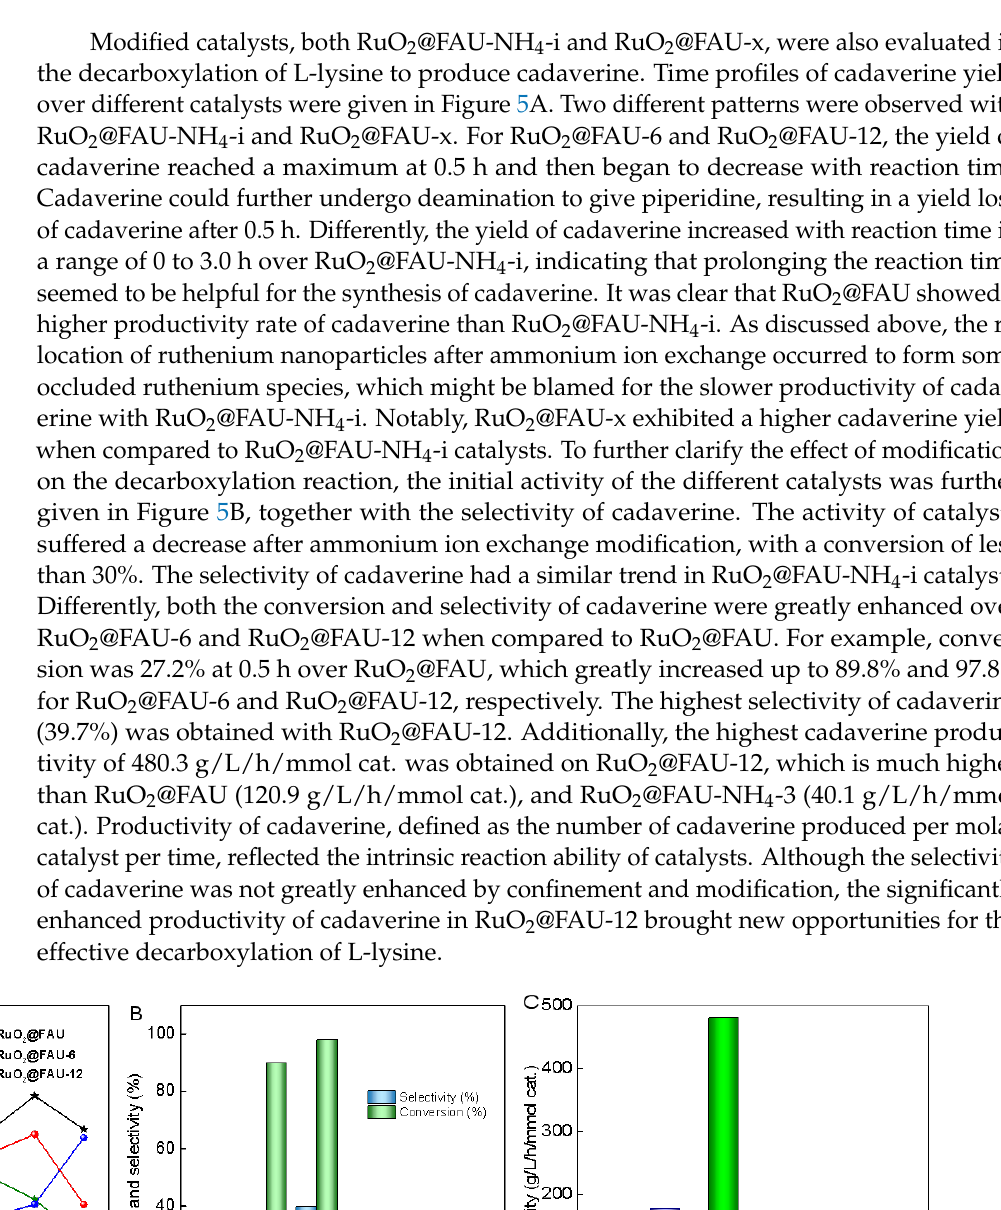
Figure 6. Decarboxylation of L-lysine to cadaverine with RuO 2 @FAU, and RuO 2 @FAU-12 and RuO 2 @FAU-NH 4 -3 catalysts. ( A ) variation of conversion with reaction time, ( B ) variation of the selectivity of cadaverine with reaction time. ( C ) acid content comparison of RuO 2 @FAU, and RuO 2 @FAU-12 and RuO 2 @FAU-NH 4 -3. Our previous work showed that active surface oxygen vacancies in catalysts facilitated the adsorption of intermediate in the decarboxylation of L-lysine [13]; therefore, the relationship between the quantity of oxygen vacancies in catalysts and their catalytic performances were studied. The high-resolution O 1 s spectra for RuO 2 @FAU, RuO 2 @FAU-12 and RuO 2 @FAU-NH 4 -3 catalyst were depicted in Figure 7A–C. The peak area of O α1 , O α2, O β and O γ were calculated. The density of oxygen vacancies (O v ) could be assumed as O β /(O α + O β + O γ ). For RuO 2 @FAU, the peak of O α2 shifted to 530.8 eV for RuO 2 @FAU-12 catalyst and to 531.7 eV for RuO 2 @FAU-NH 4 -3 catalyst, respectively. The shift in the binding energy for crystal oxygen of FAU in modified catalysts might be due to the distorted crystalline structure which has been described above in Figure 3A. According to the literature, 32–33 peaks at the binding energy of 530.9 eV for RuO 2 @FAU,